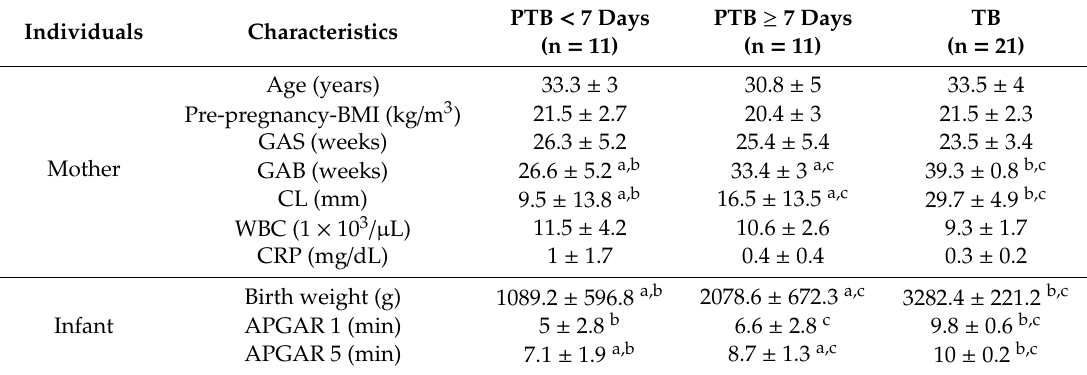
Figure 1. Study flowchart for the subject selection criteria. PTB: preterm birth; TB term birth; PTB < 7 d: preterm birth less than 7 days after cervicovaginal fluid (CVF) sampling, PTB ≥ 7 d: preterm birth more than 7 days after CVF sampling. Table 1. Clinical characteristics of subjects.